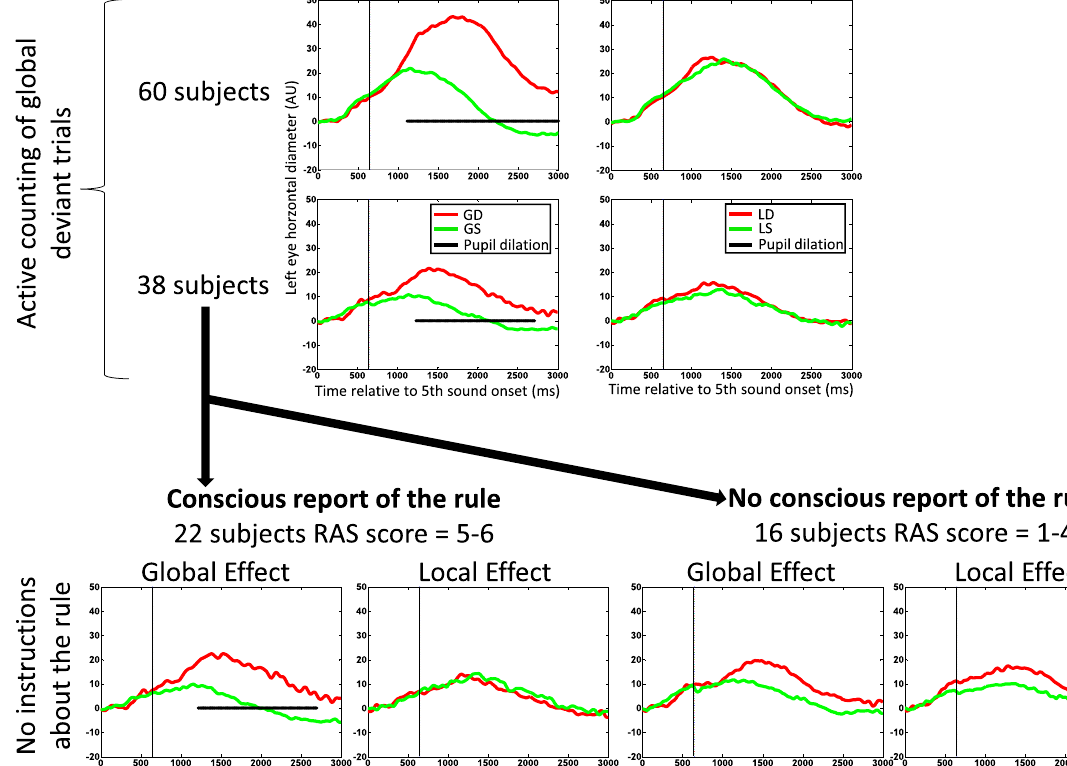
Figure 4. The pupil dilation global effect occurred only in participants aware of global regularity violations Using the same visual codes as in Fig. 3, a significant pupil dilation effect occurred in response to violation of global regularity, and not to violations of local regularity (artefact interpolation method; 2 upper panels). A subset of these 60 participants (N = 38) performed first a passive attentive version of the task during which they were not instructed about the structure of stimuli, and did not have to count global deviants, and were then submitted to a post-experimental regularity awareness score (RAS) to distinguish participants who consciously accessed to global regularity (RAS ≥ 5; N = 22) from those who did not (RAS < 5; N = 16). Finally they also performed an active counting version of the task. During the active counting task this subset of 38 participants showed the exact same pattern of results in the total group of 60 participants (two middle panels). In the passive attentive version of the task, only participants aware of global regularity showed a pupil dilation to global deviant